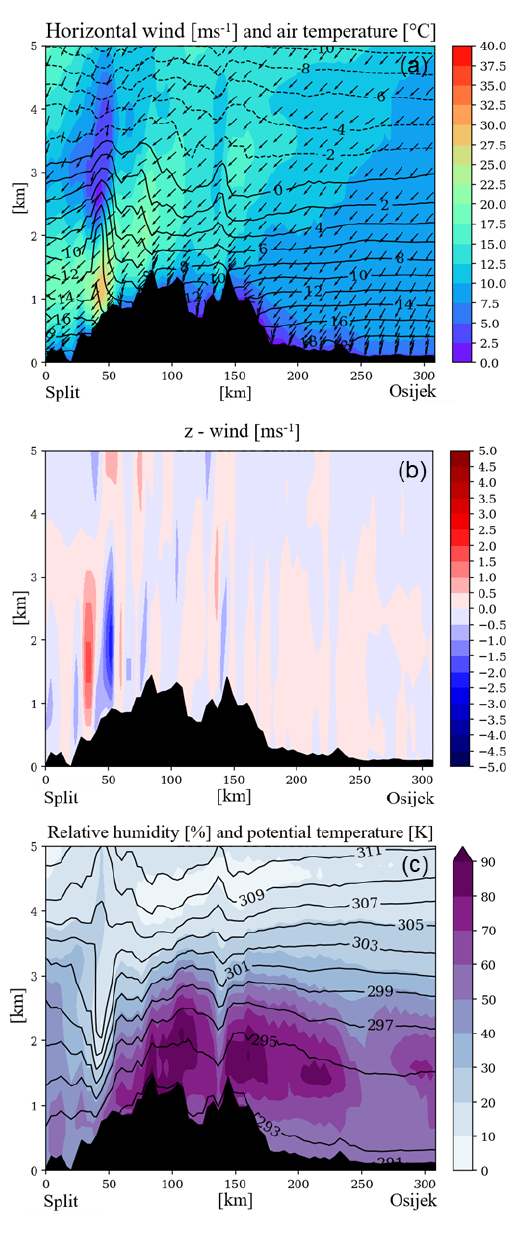
Figure 12. Vertical cross-sections from the ALADIN-HR44 model of (a) horizontal wind speed (ms − 1 ; colored) and direction (vector) and temperature ( ◦ C; black contours for ≥ 0 ◦ C, dashed contours for < 0 ◦ C), (b) z wind (ms − 1 ; colored), and (c) relative humid- ity (%; colored) and potential temperature (K; black contours every 2K), all valid for 23:00UTC on 16 July 2017 from the ALADIN model. The bottom black area depicts the terrain. The location of the cross-section between the cities of Split and Osijek is indicated in Fig. 1a. Each section is 300km long and 5km high, oriented north- east to southwest and perpendicular to the Adriatic coast, with Split situated approximately 20km from the bottom left corner. Airflow in each panel is from right to left.